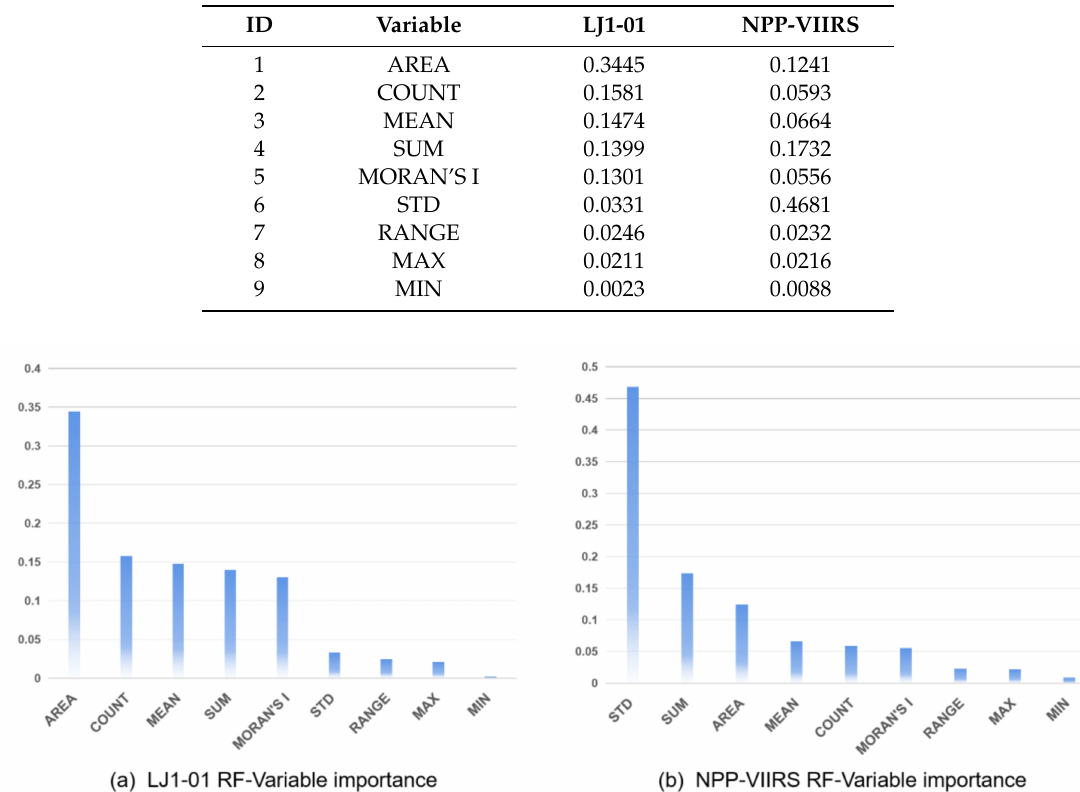
Table 7. Importance of each variable for LJ1-01 and NPP-VIIRS in the RF model.